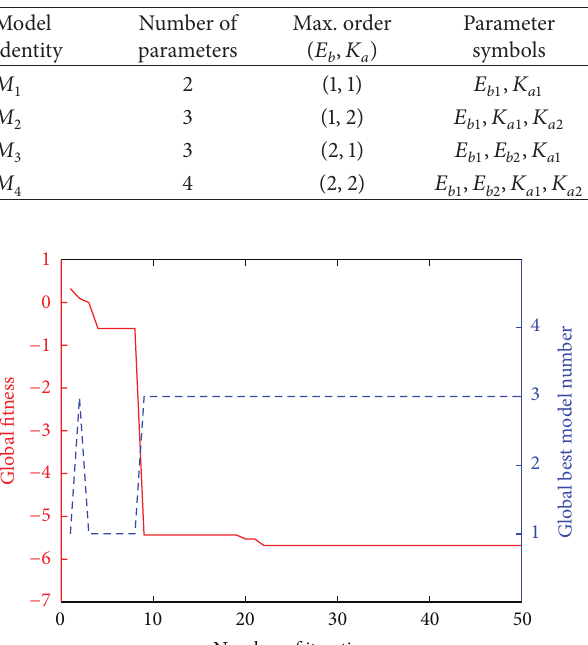
Table 5: Model parameterization.